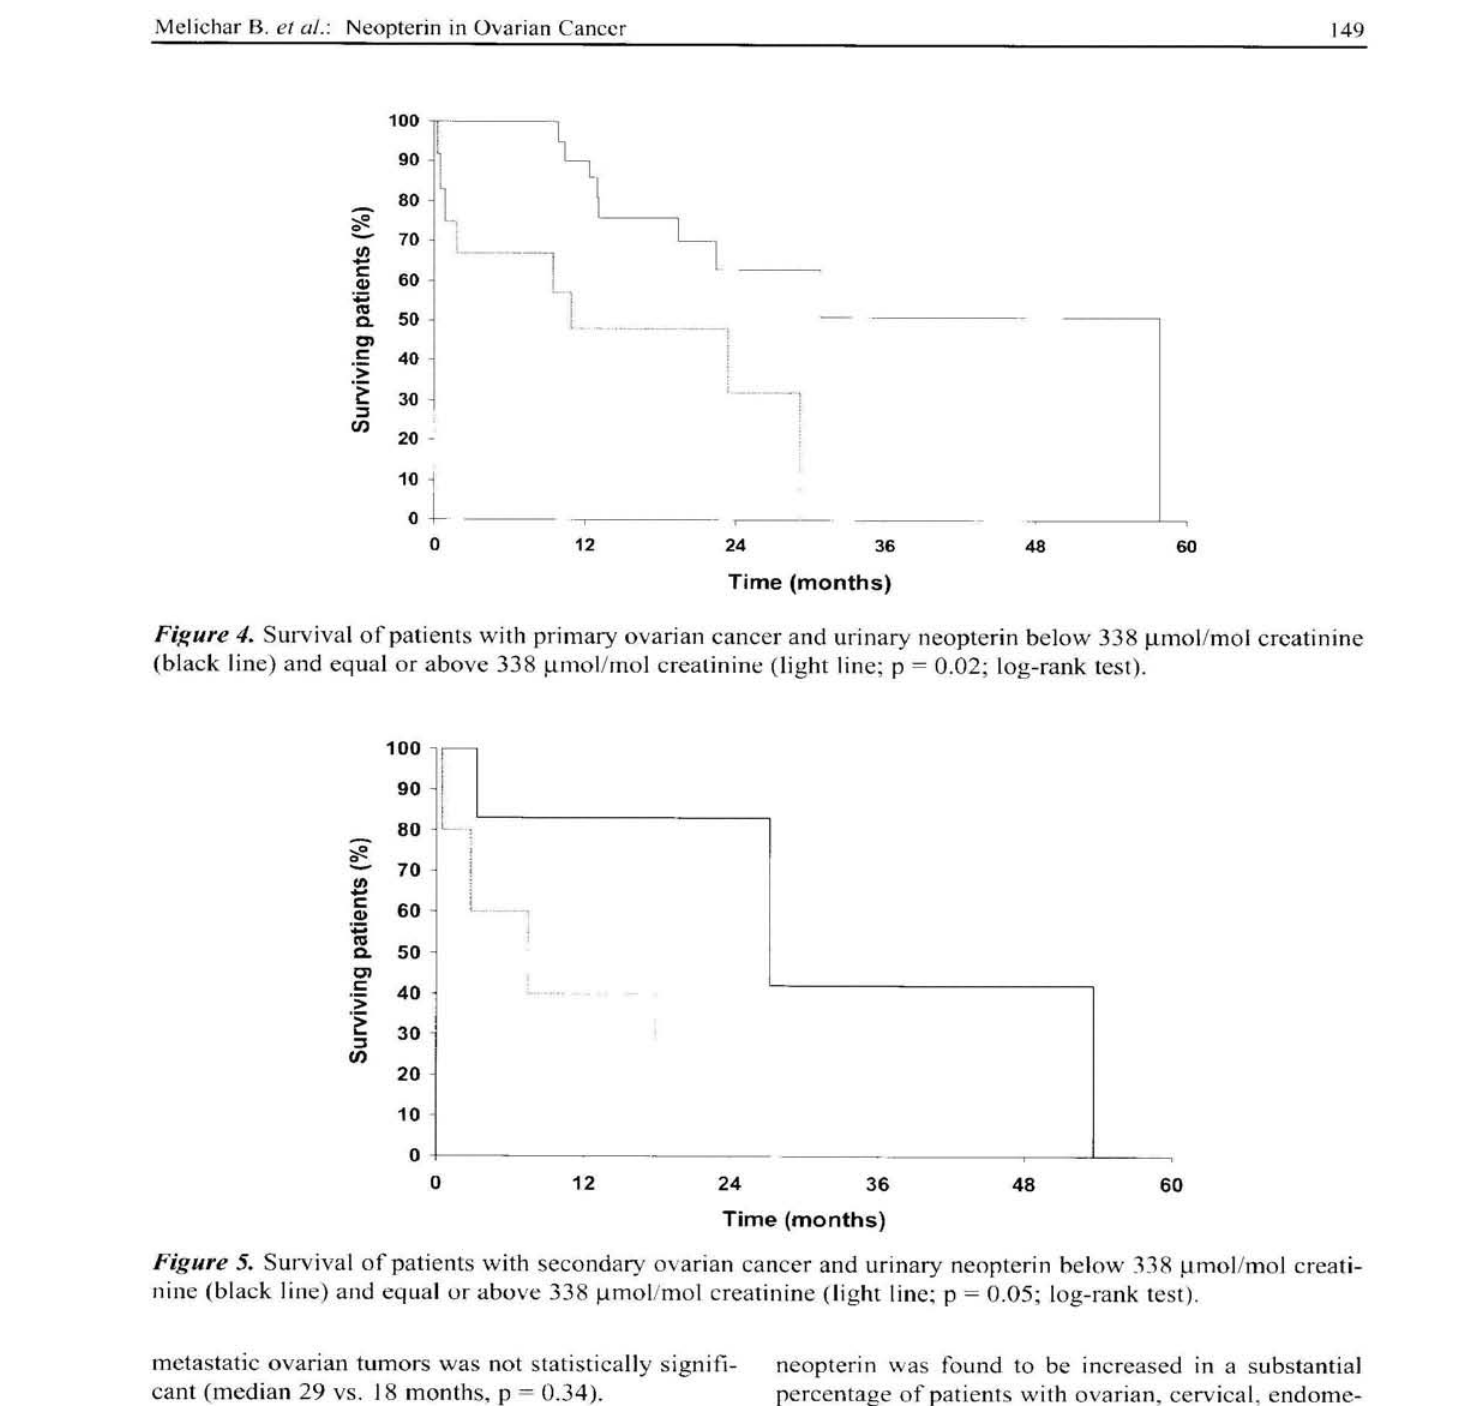
metastatic ovarian tumors was not statistically signifi- cant (median 29 vs. 18 months, ρ =